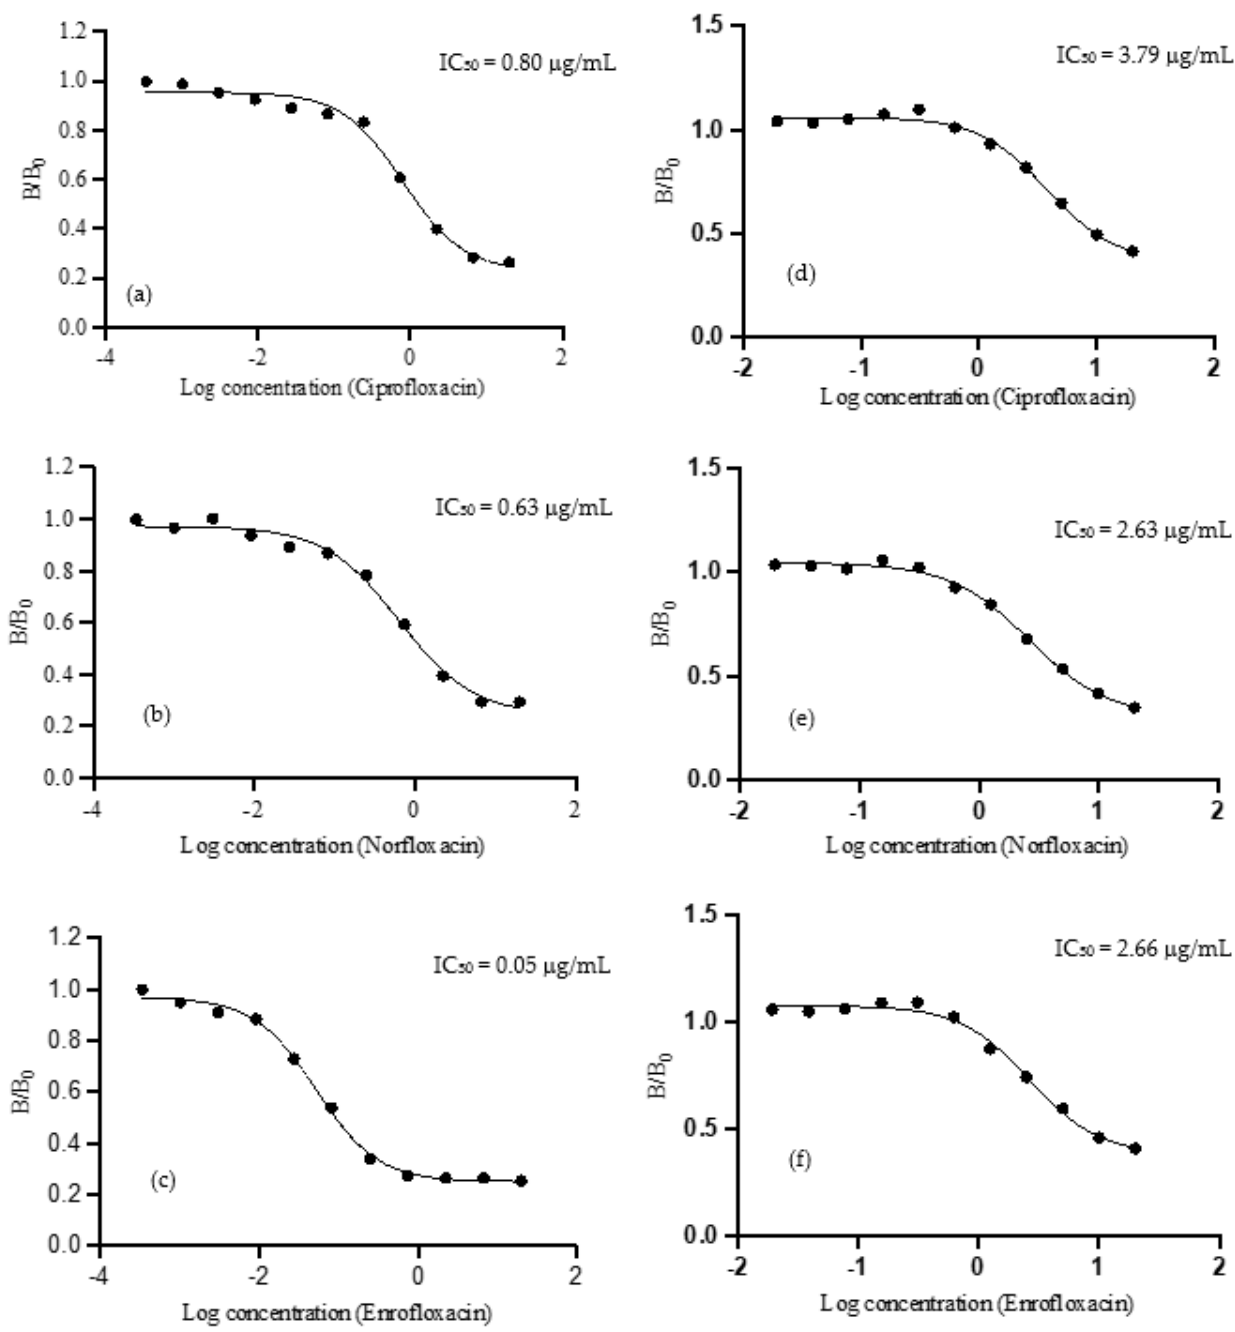
Figure 4. The inhibition curve of fluoroquinolone antibiotics using mixed CPFX–BSA and NFX–BSA activation of the antibody, ( a – c ) using CPFX–OVA as the coating antigen; ( d – f ) using NFX– OVA as the coating antigen.